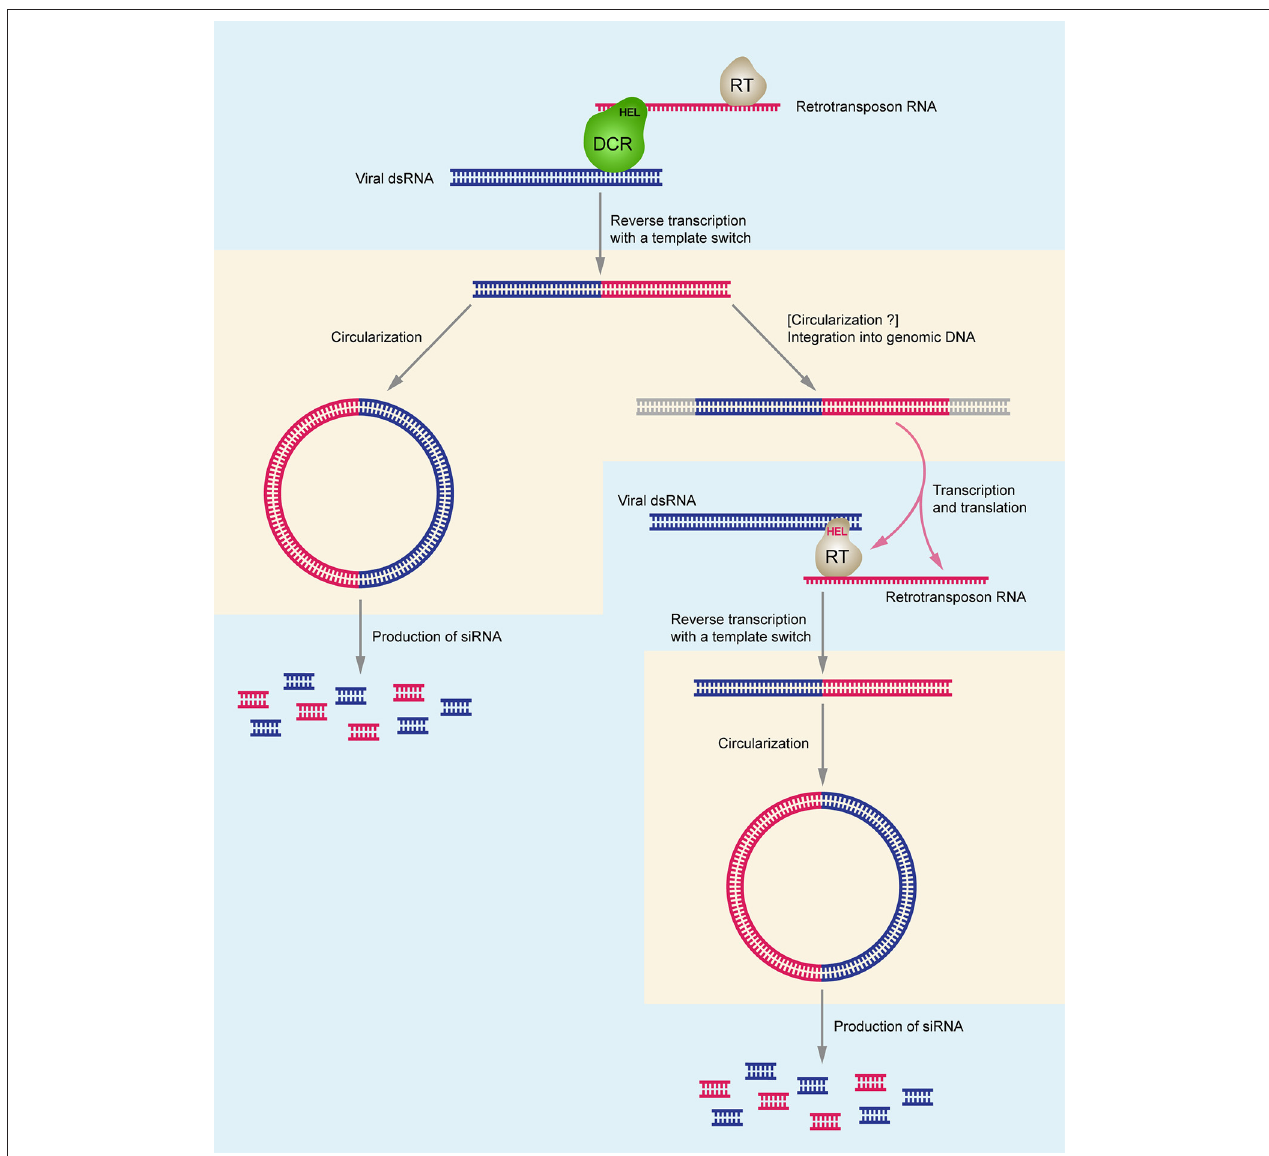
FIGURE 1 | Schematic model of chimeric DNA synthesis and the interactions between DCR-HEL (RT-HEL), reverse-transcriptase (RT), retrotransposon DNA and viral dsRNA. Uptake of viral genomic RNA and synthesis of double-stranded replicative form RNA in cell cytoplasm stimulates chimeric circular and linear DNA production which allows increased de novo synthesis of virus-specific small RNAs and efficient antiviral RNAi response. Right part of the figure shows the hypothetical pathway specific for Lepidoptera insect species. DCR-HEL is shown in green; RT-HEL is shown in gray. Retrotransposon-specific RNA, DNA, and RNAi are shown in red; virus-specific RNA, DNA, and RNAi are shown in blue. DNA-specific steps are shown in pinkish areas; RNA-specific steps are shown in bluish